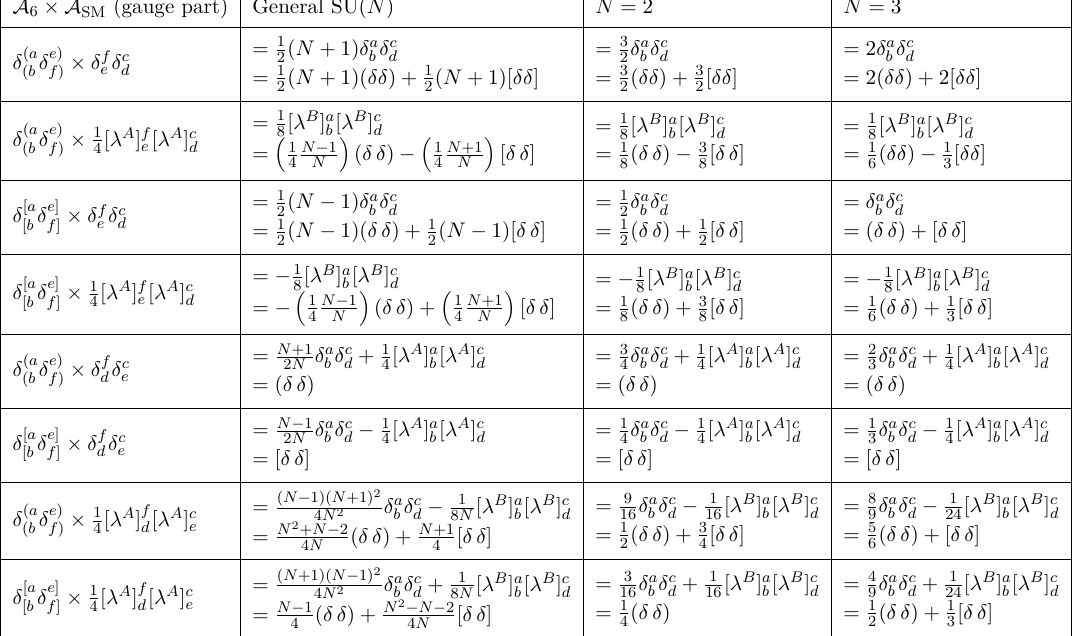
Table 14 . Possible gauge contractions appearing in A 6 × A SM , starting from (anti)symmetrised structures in A and expressing the result in terms of non-symmetrised structures and, equivalently, 6 completely in terms of (anti)symmetrised structures for A . The identities are valid for SU( N ) 6 generators λ A normalised such that Tr[ λ A λ B ] = 2 δ AB , and which reduce to the Pauli (Gell-Mann) matrices when N = 2(3)